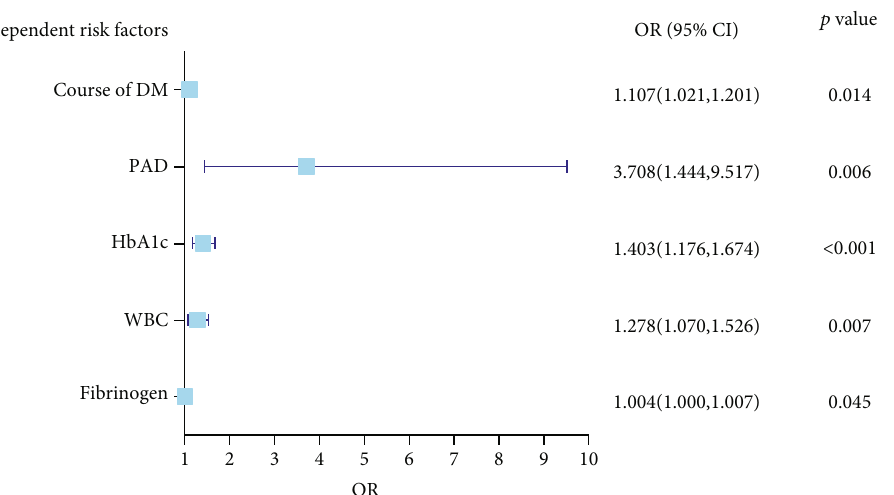
Figure 1: Plot of independent risk factors predicting the risk of amputation in patients with diabetic foot ulcer based on multivariate logistic regression analysis.